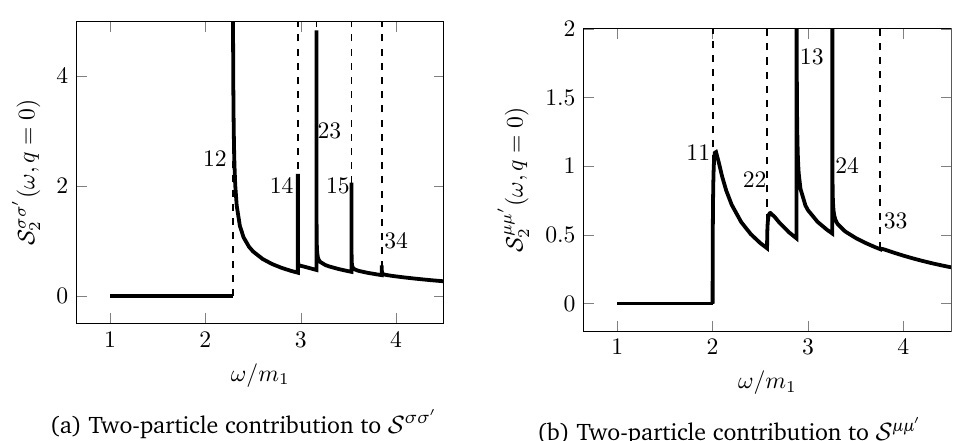
Figure 7.3: Two-particle contributions to the mixed dynamical structure factors of the leading and subleading magnetisation and disorder operators.